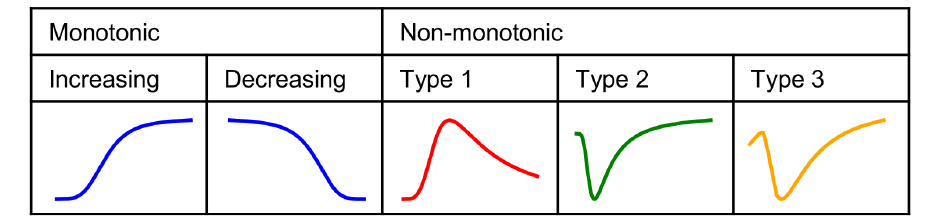
Fig 3. Classification of (non-)monotonic